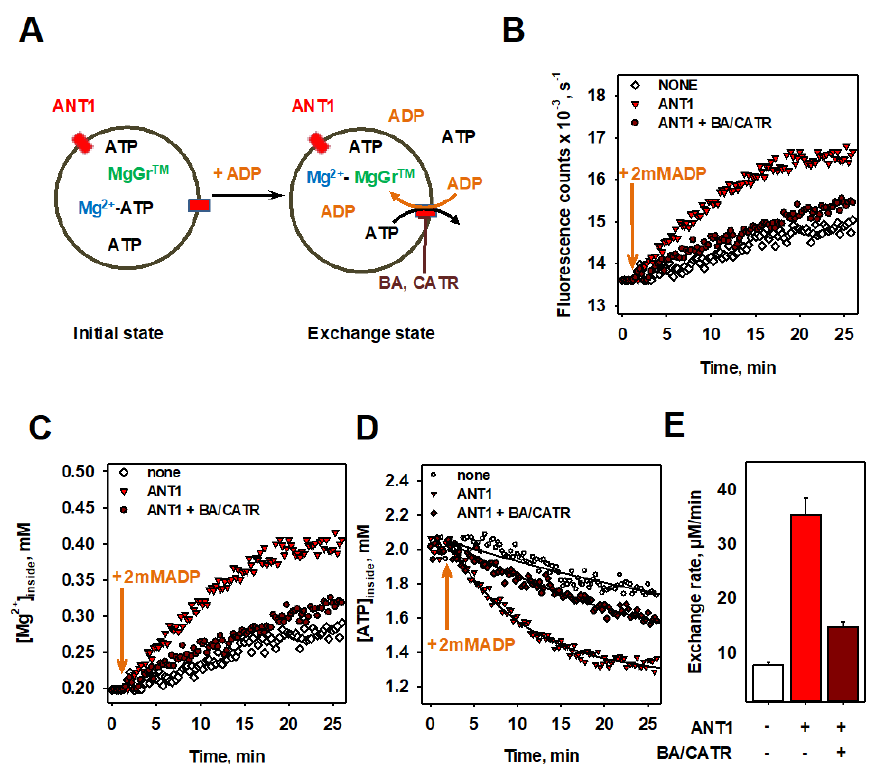
Figure 2. ADP / ATP exchange rate measurements using a fluorescence-based assay. ( A ) A scheme of the fluorescence-based assay of (proteo-)liposomes with internal Magnesium Green (MgGr) TM . The measurements started with the addition of ADP at time point t = 2 min (arrows). ( B ) Time dependence of the fluorescence intensity, ( C ) calculated [Mg 2 + ], and ( D ) calculated [ATP] in the presence (red triangles) and absence (open circles) of ANT1, and in the presence of BA and CATR (red diamonds). ( E ) Maximal ADP / ATP exchange rate of liposomes (open bars) and ANT1 containing proteoliposomes in the absence (red bars) and presence (dark red bars) of ANT1 inhibitors (BA and CATR). Values were obtained as a fit parameter from ( D ). In all measurements, the bu ff er contained 50 mM Na 2 SO 4 , 10 mM Tris, 10 mM MES and 0.6 mM EGTA at pH = 7.34 and T = 297 K. Lipid membranes were made of DOPC, DOPE and CL (45:45:10 mol%). The lipid concentration was 1.0 mg / mL and the liposome diameter was approximately 100 nm. Concentrations of ATP, ADP, Mg 2 + and MgGr TM were 2 mM, 2 mM, 1 mM and 3 µ M, respectively. The concentrations of ANT1 and inhibitors (BA, CATR) were 8.67 µ g / mL and 100 µ M, respectively. Data are shown as the mean ± SD of at least three independent measurements.